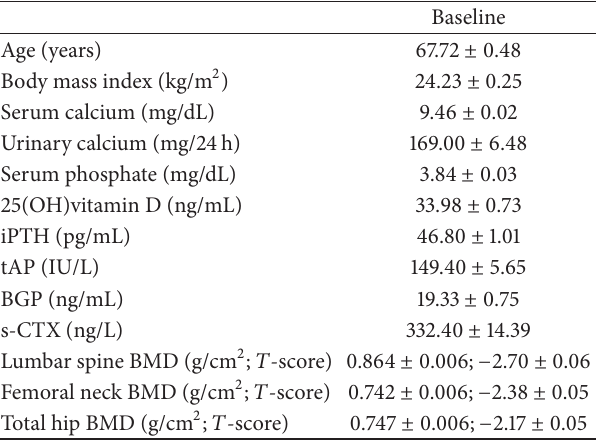
Table 1: Baseline clinical characteristics of all patients ( 𝑛 = 425